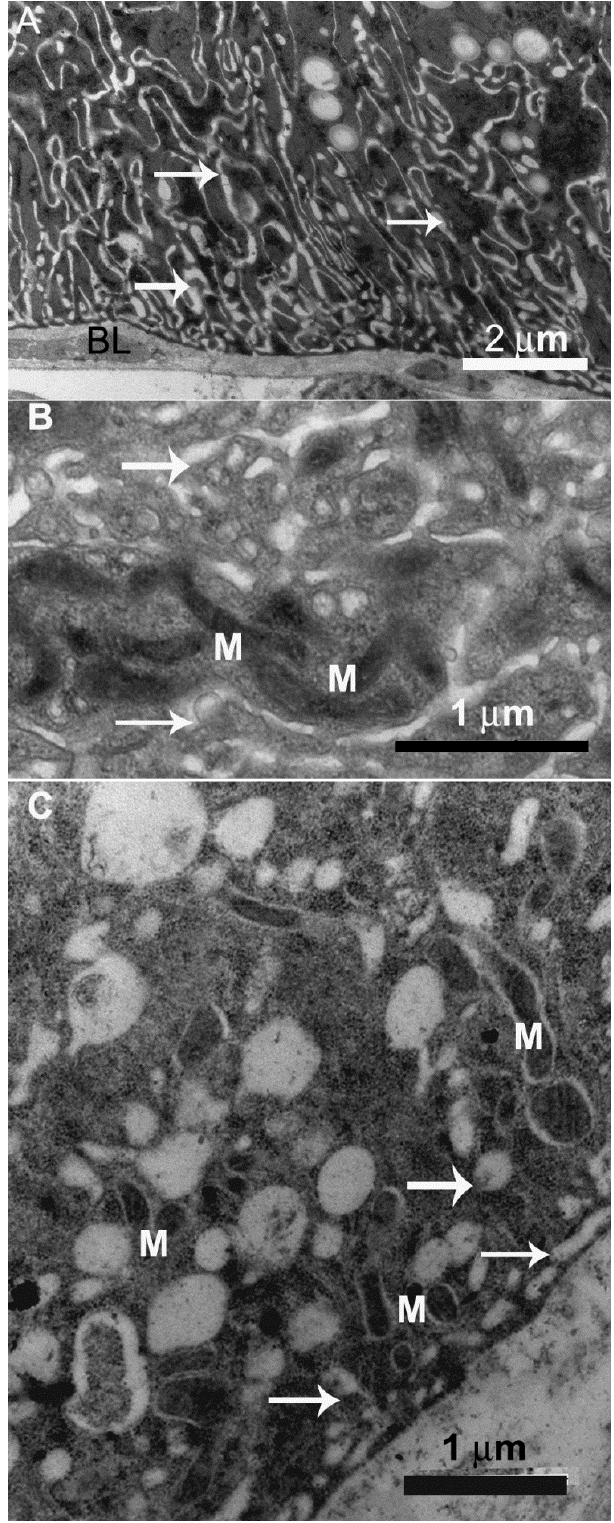
Figure 5. Transmission electron micrographs of digestive cell in the midgut of Friesella schrottkyi worker. ( A ) Basal region of the digestive cell in the anterior midgut region showing many plasma membrane infoldings forming extracellular channels (arrows). BL—basal lamina. ( B ) Details of extracellular channels (arrows) associated with mitochondria (M). ( C ) Basal region of the digestive cell in the posterior midgut region showing extracellular channels (arrows) associated with mitochondria (M).